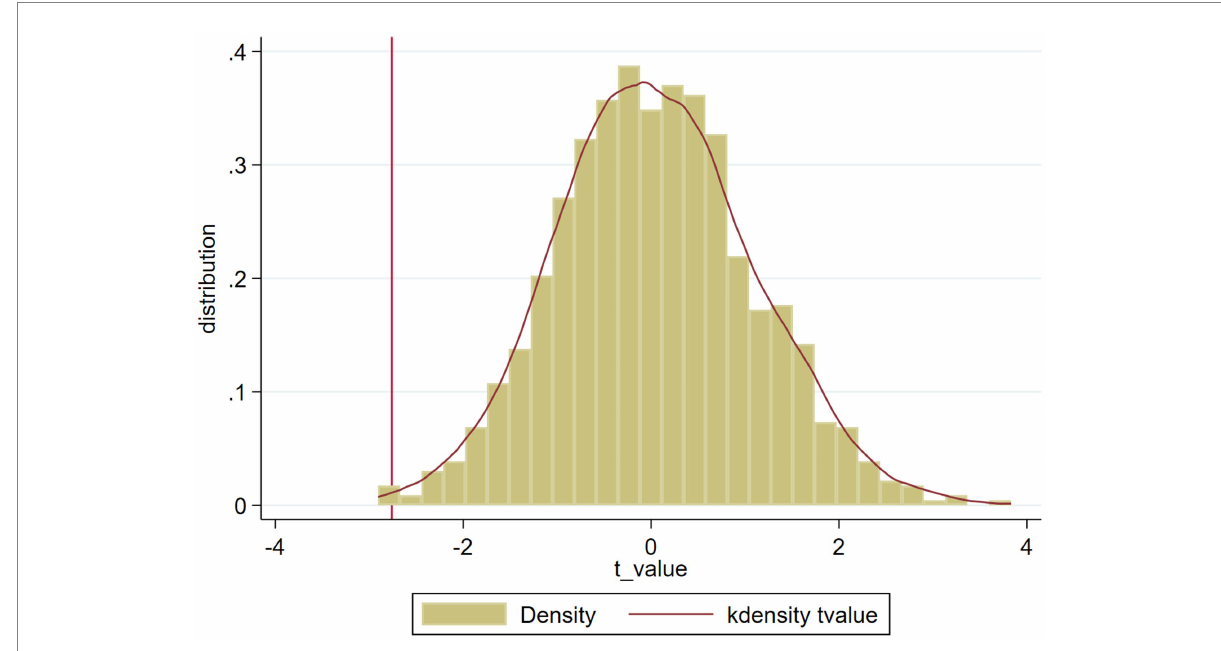
FIGURE 2 T-value distribution of placebo test. This figure depicts the distribution of T-values obtained from 1000 placebo tests. The vertical solid line represents the T-value of the standard regression cross-multiplication term, as shown in column (2) of Table